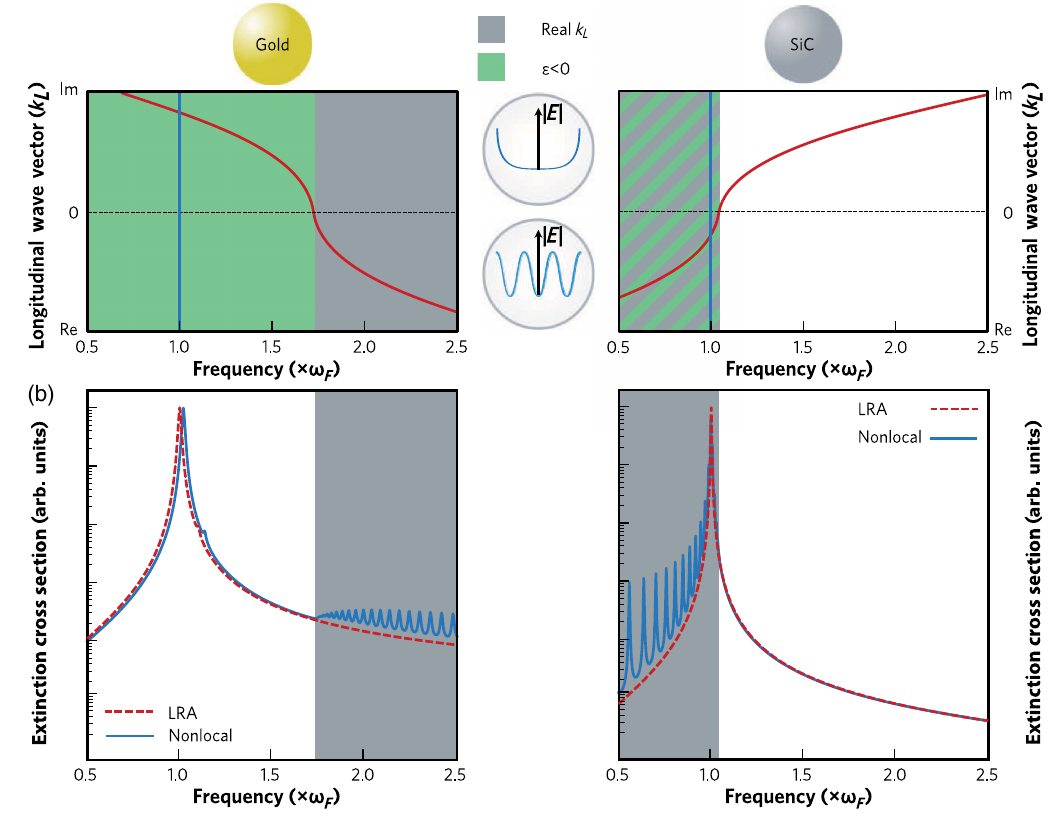
FIG. 1. (a) Illustration of nonlocal effects in gold and SiC nanospheres. The two panels illustrate the dispersion of the longitudinal plasma (left) and longitudinal optical phonon (right) as a function of frequency. Regions with real wave vector solutions are shaded gray. Green shading illustrates instead the region where the dielectric function is negative and can sustain surface modes, plasmonic or ω − 2 , is shown by the solid blue line, and the frequency axis is phononic. The Fröhlich resonance frequency, where ϵ F Þ ¼ LRA ð normalized to ω in each case. The two spheres in the center sketch the longitudinal mode electric field distribution in the case of F imaginary (top) and real (bottom) wave vectors, relevant, respectively, for the metallic and dielectric cases. (b),(c) Extinction cross section for a 10-nm-radius (b) gold and (c) 3 C -SiC nanosphere. Results calculated with a local response approximation (LRA) are shown by red dashed curves, and those calculated with a full nonlocal model by blue solid curves. Parameters used in the calculations for both gold and 3 C -SiC are reported in Appendix